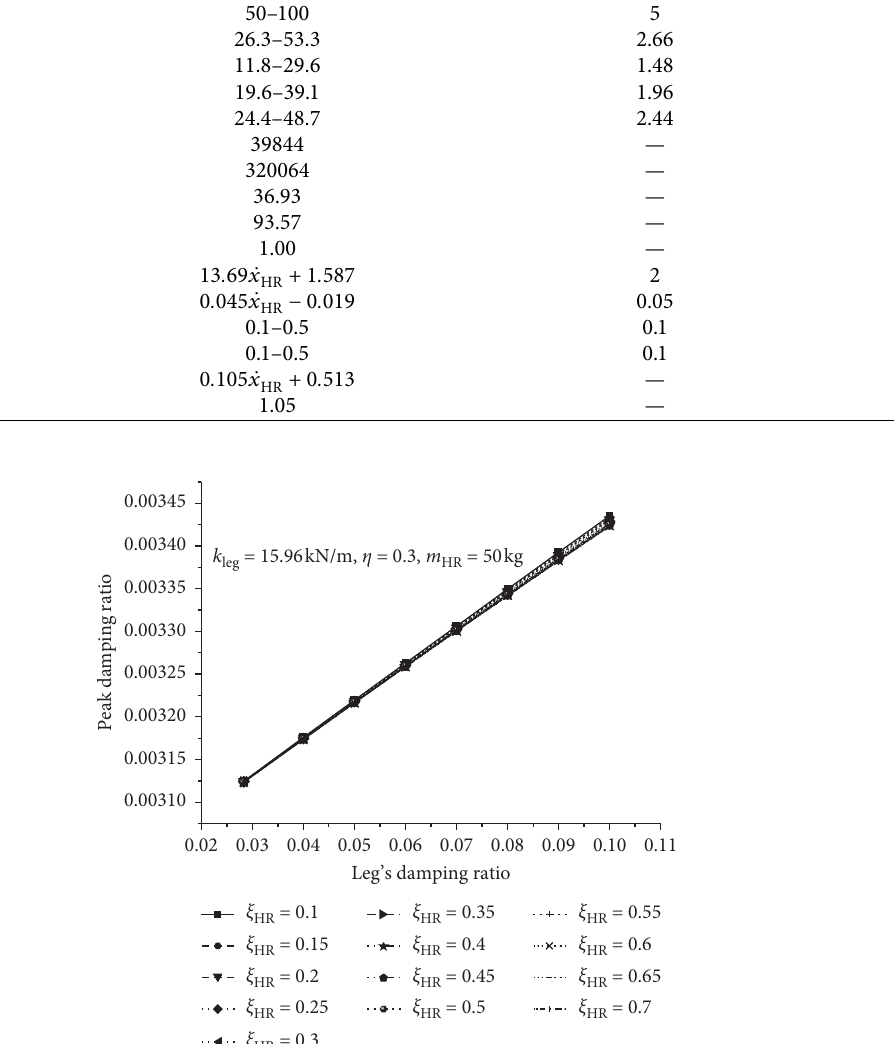
� 50kg, and ξ � 0 . HR leg